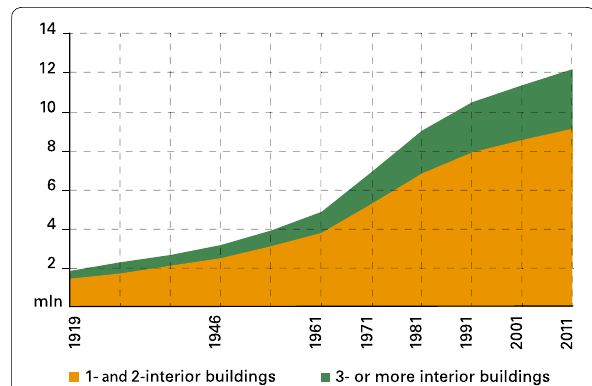
Fig. 1 The weight of one- and two-interior buildings out of the total residential stock. The curve trend shows the evolution up to 2011, and the most intense growth phase of the family house in the 1960s–1980s period (authors’ calculations on data from Istat census).